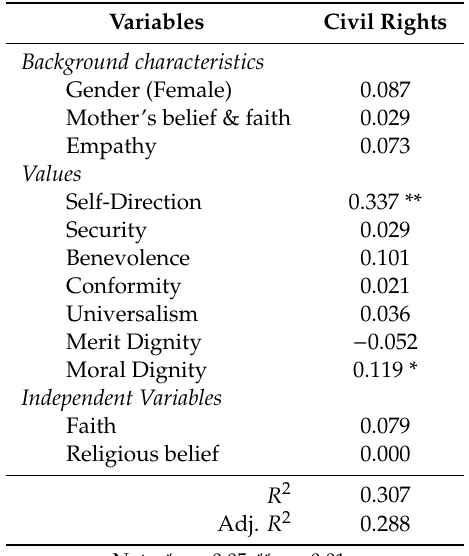
Table 11. Regression analysis for civil rights with weights ( β ) for each variable and total explained variance ( R 2 and adjusted R 2 ).